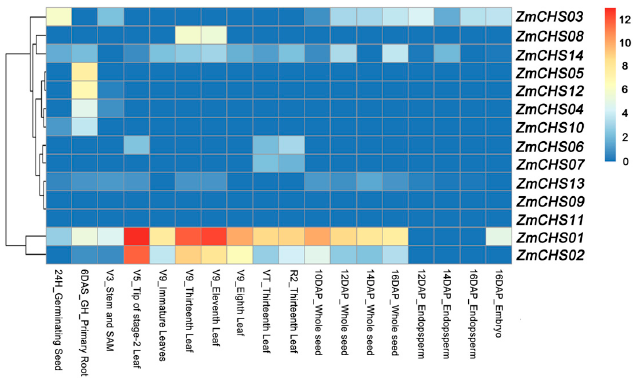
Figure 6. Clustering of expression profiles of 14 ZmCHS genes. Different organs/tissues are exhibited below each column. 24H, 24 h after imbibition; DAS, days after sowing; GH, growth hormone; SAM, Shoot apical meristem; V3, Vegetative 3, three fully extended leaves; V5, Vegetative 5, five fully extended leaves; VT, Vegetative tasseling, last branch of the tassel fully emerged; R2, Reproductive 2, 10–14 days after silk emergence; DAP, days after pollination. The names of ZmCHS genes are displayed at the right side of each row. The colour box from blue to orange indicate an increased expression